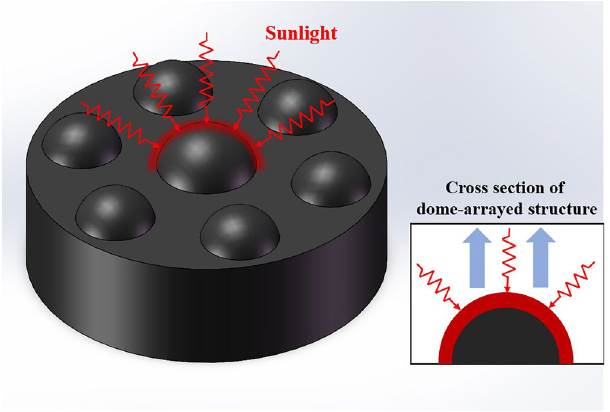
Figure 2. Optimized dome-arrayed hydrogel with hemispherical structures.